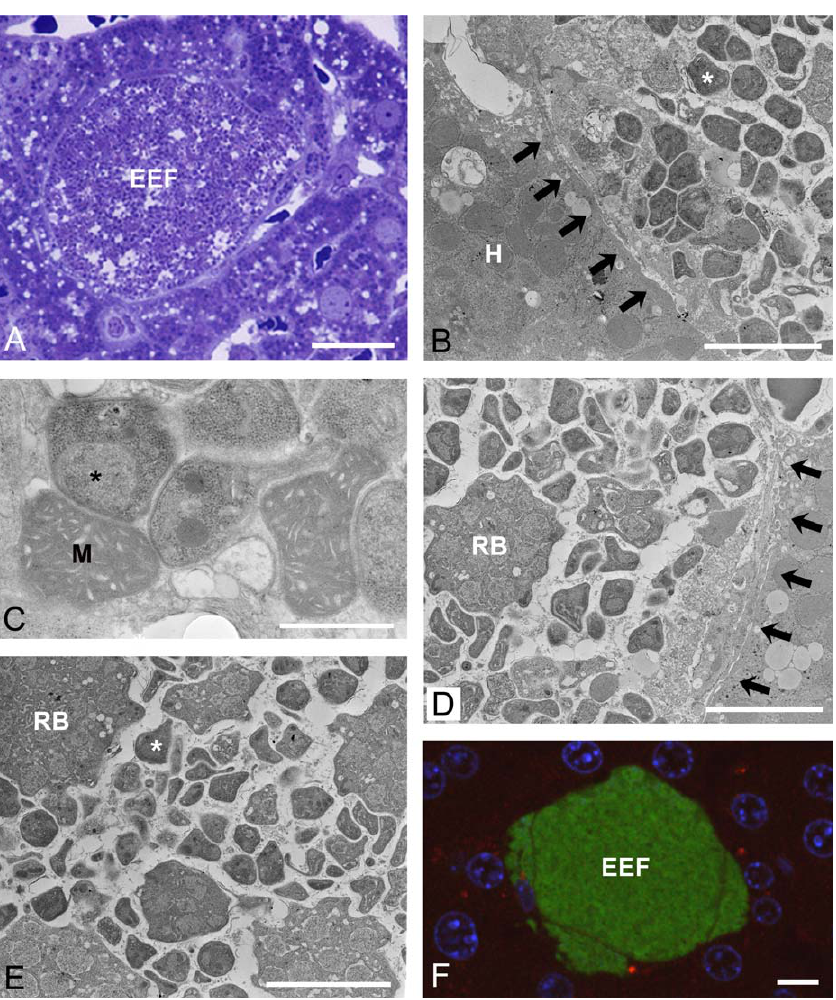
Figure 1. Characterization of Late P. yoelii